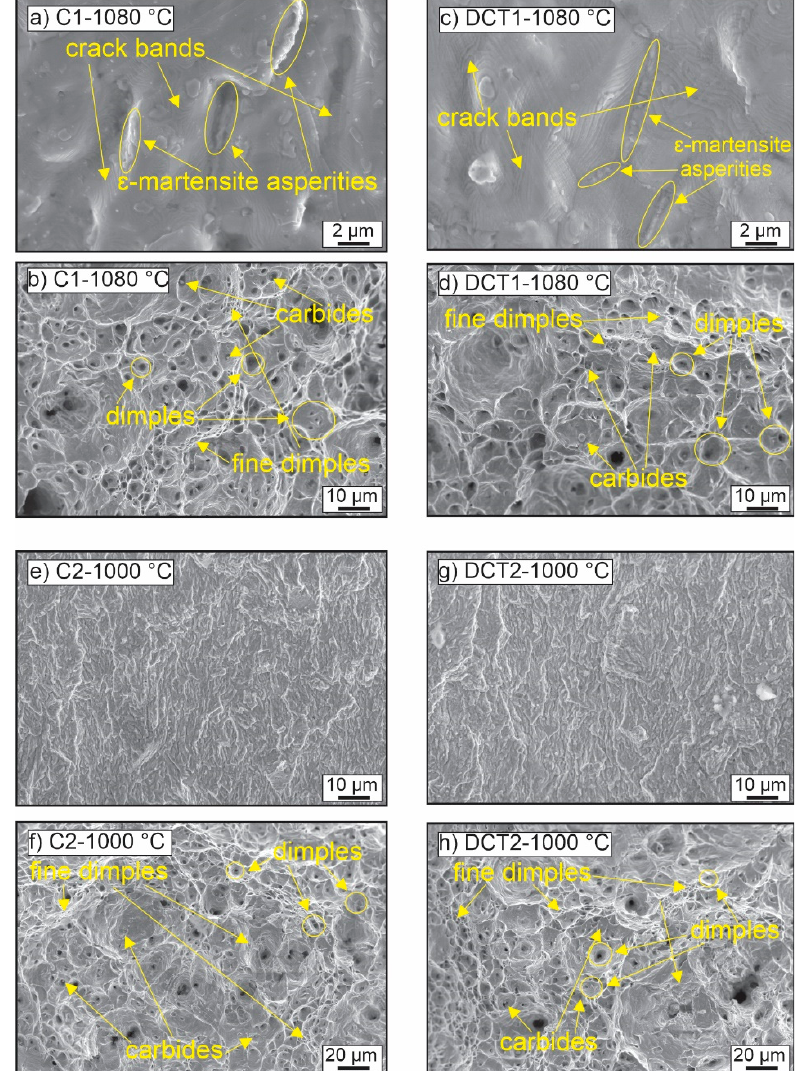
Figure 8. Fractograms of cracked samples of all four heat treatment groups (C1/C2 have conventional solution annealing, and DCT1/DCT2 are deep cryogenically treated). Images ( a , c , e , g ) present the brittle cracked region, and images ( b , d , f , h) present the ductile cracked region of the samples.